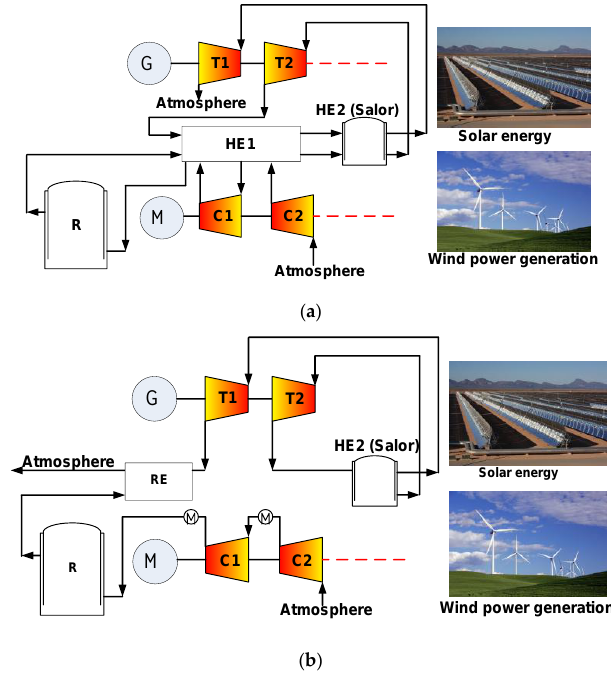
Figure 18. Schematic diagrams of CEAS with wind power generation and solar energy: ( a ) Reusing heat from compression; ( b ) Reusing waste heat from outlet of turbines (C—Compressor, T—Turbine, G—Generator, M—Motor, RE—Heat regenerator, HE—Heat storage & Exchanger) [4].